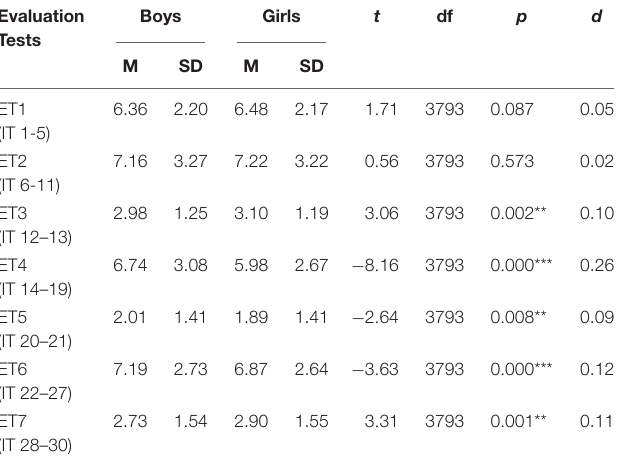
TABLE 4 | t test for independent samples by sex for each evaluation tests. Evaluation Tests